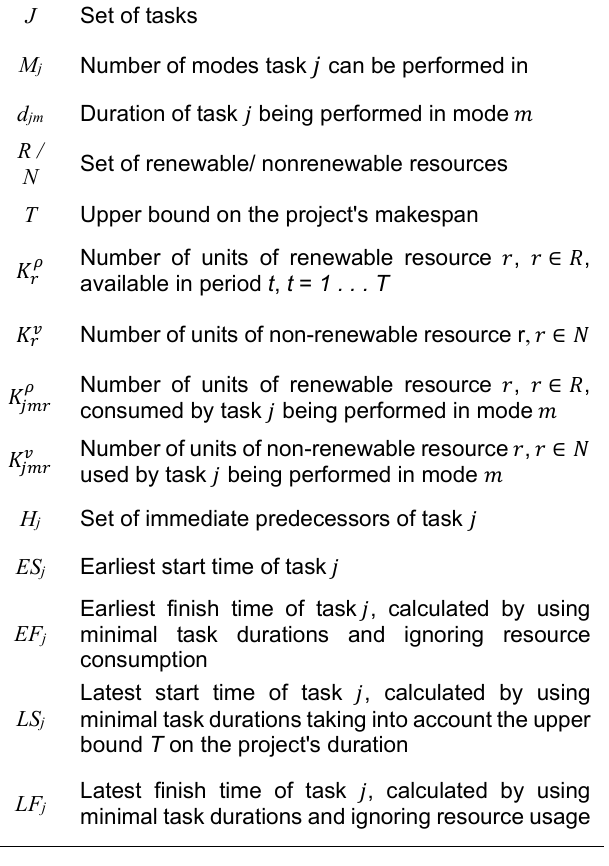
Table 1. Notation and